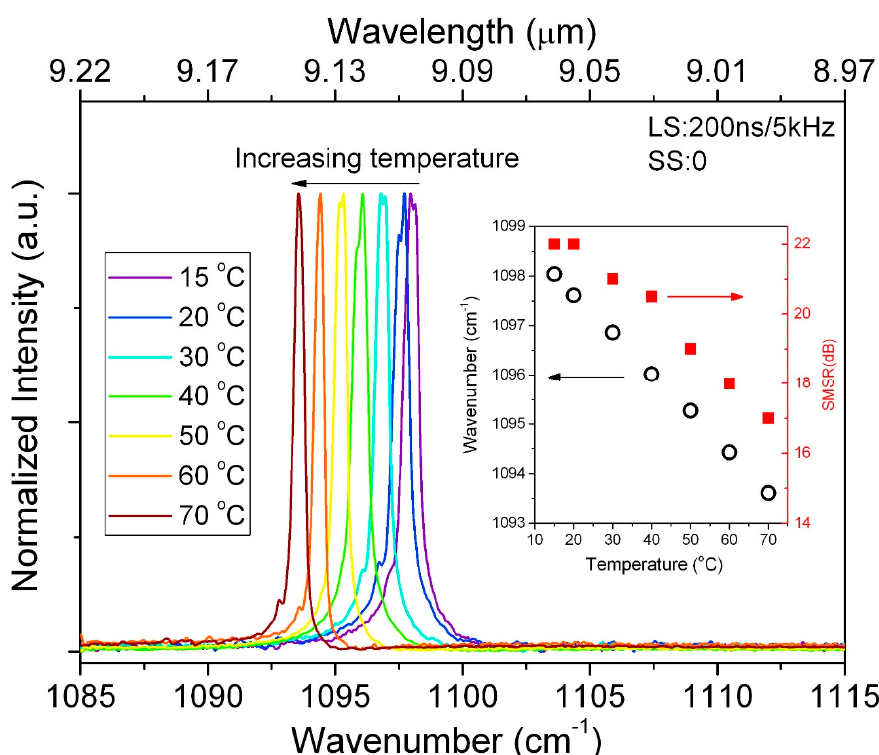
Figure 7. Emission spectra of the CC-QCL operated at the constant current level I = 1.15 I th and various heat sink temperatures. Inset shows the single mode emission wavenumber and side mode suppression ratio (SMSR) vs. heat sink temperature.